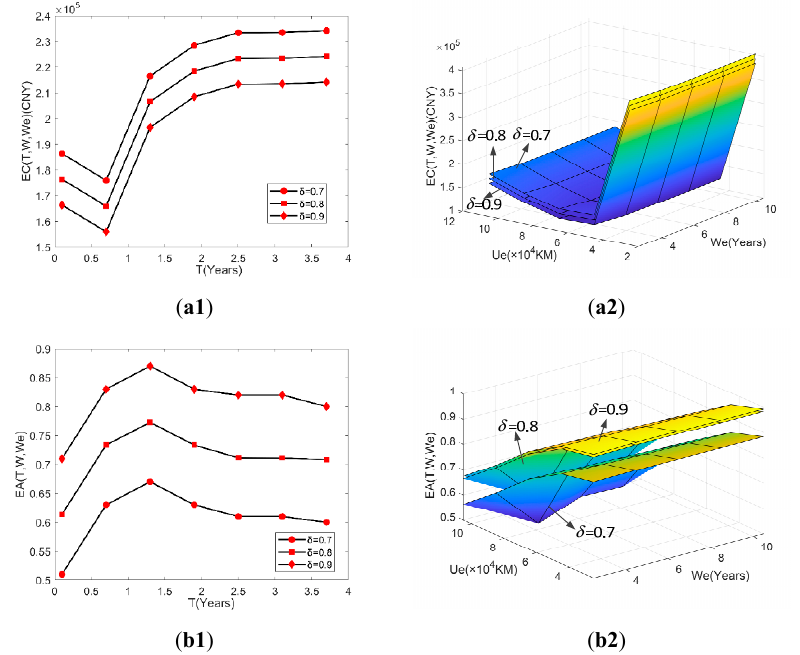
δ . ( a1,a2 ) Warranty cost as a function w hen δ changes.